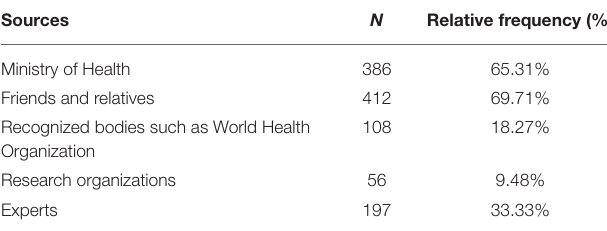
TABLE 6 | COVID-19 information sources.